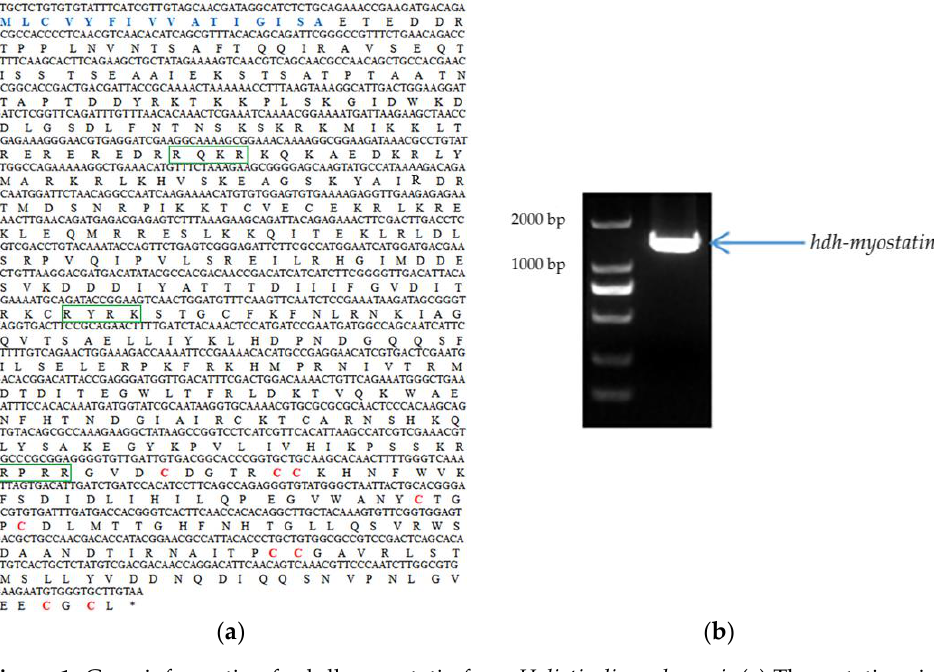
Figure 1. Gene information for hdh-myostatin from Haliotis discus hannai . ( a ) The putative signal peptide is shown in blue. The three proteolytic processing sites are denoted by green frames. The cysteine residues are shown in red. ( b ) Agarose gel electrophoresis diagram of hdh-myostatin .